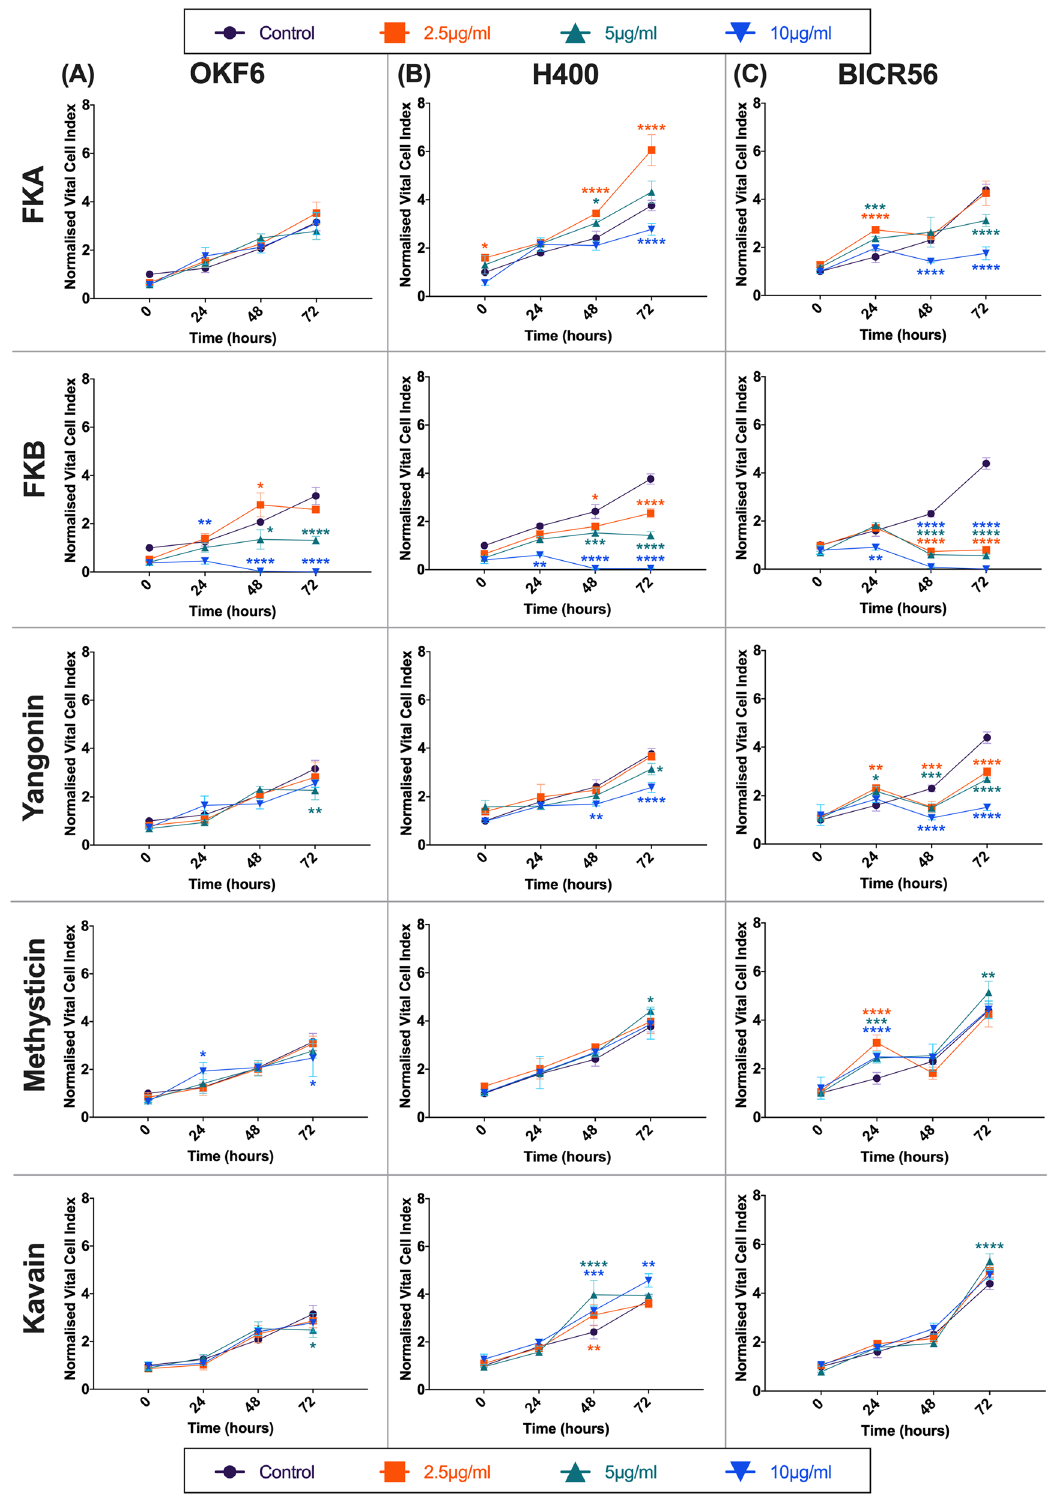
Figure 3. MTS assay. the effect of 2.5 μg/ml, 5 μg/ml and 10 μg/ml of FKA, FKB, yangonin, methysticin and kavain on OKF6 ( A ), H400 ( B ) and BICR56 ( C ) cell proliferation. Data are represented as mean ± SD. Statistical significance is given as follows: * p < 0.05, ** p < 0.01, *** p < 0.005, **** p < 0.001; compared to control